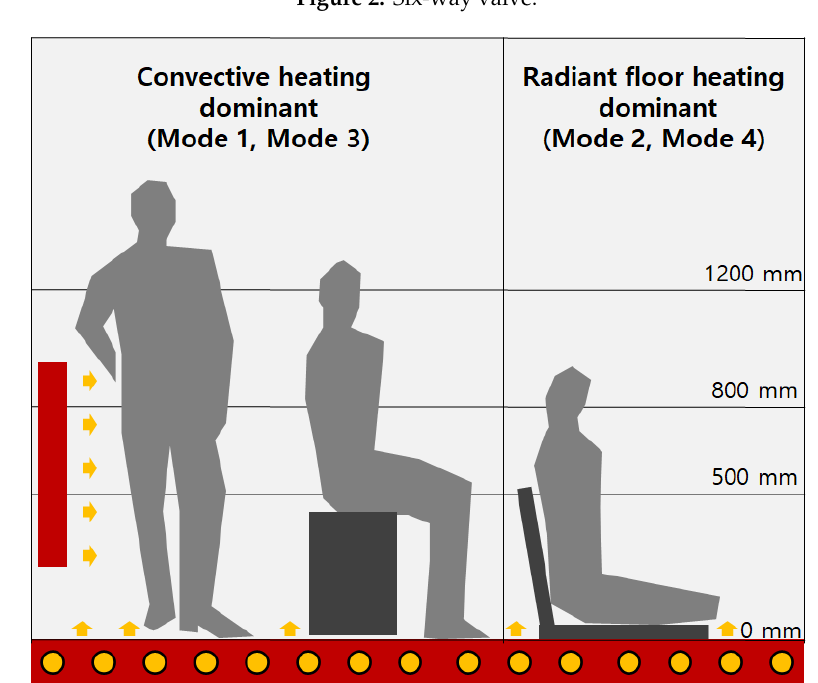
Figure 3. System operating modes.